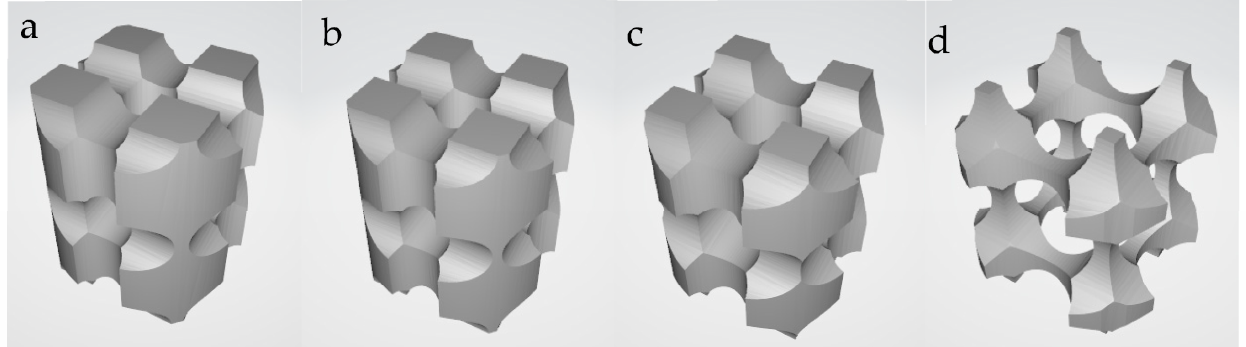
Figure 3. Three-dimensional solid models of implants with different apertures; ( a ) is 200 μm, ( b ) is 300 μm, ( c ) is 400 μm, and ( d ) is 500 μm.